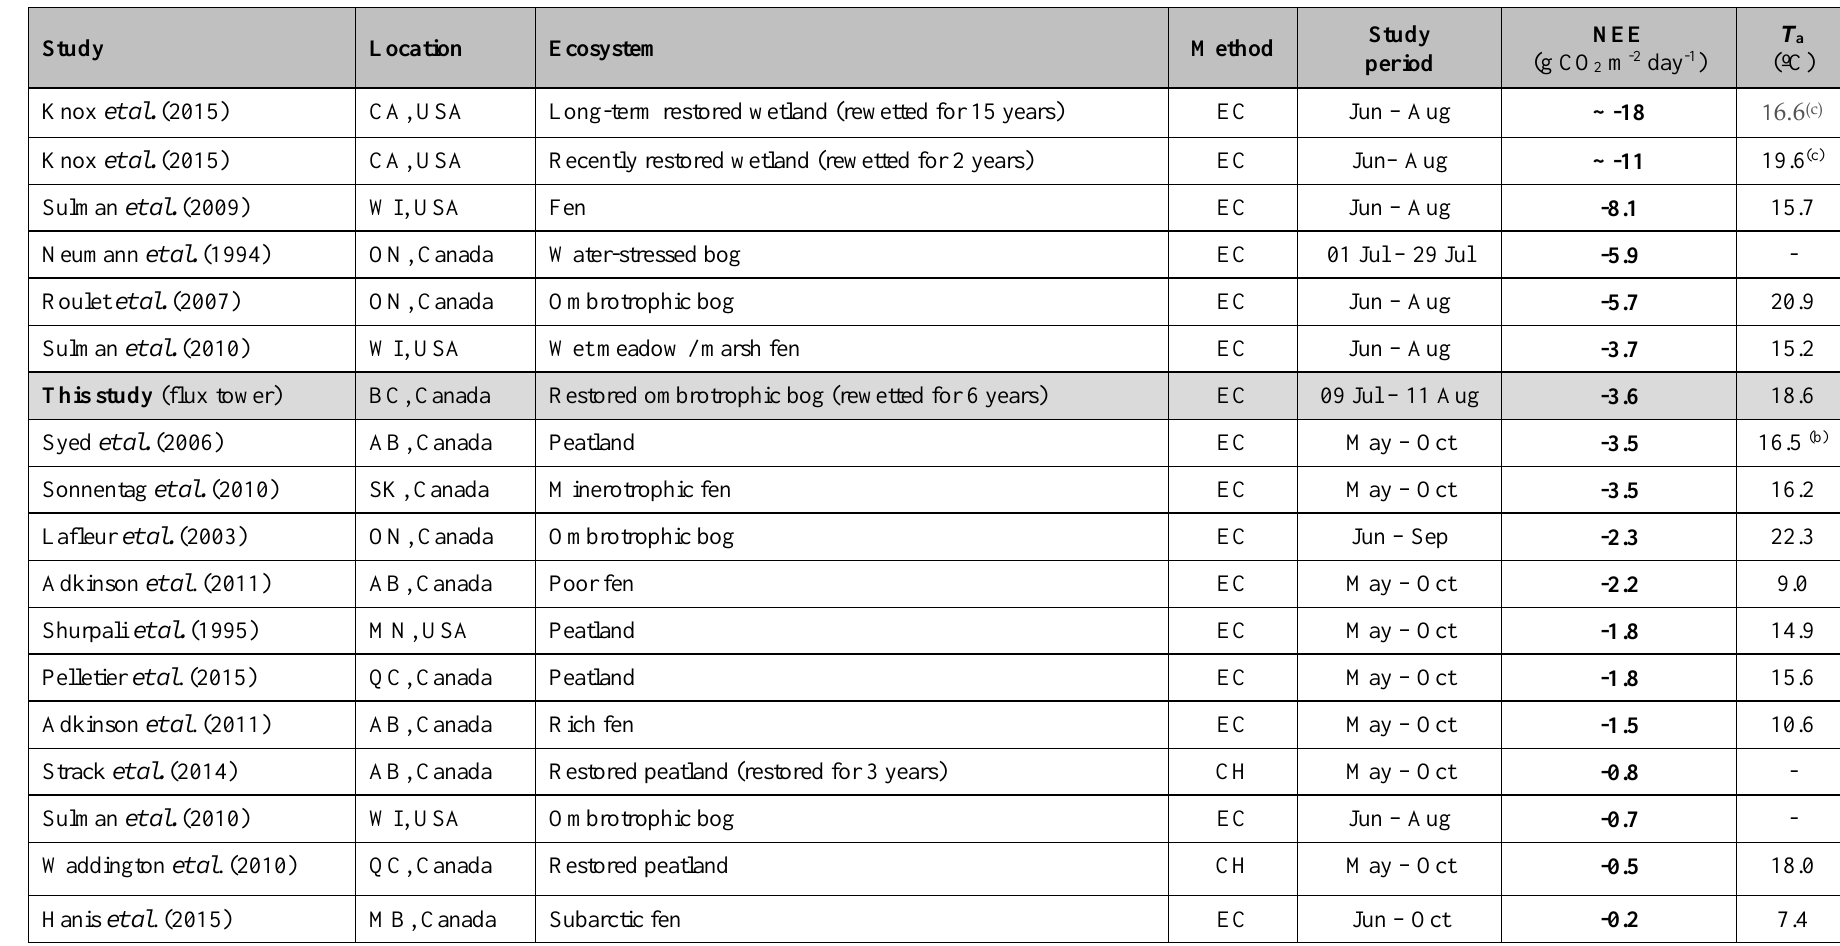
Table 5. Comparison of summertime net ecosystem exchange (NEE) measured in various undisturbed and restored temperate and boreal wetlands in North America using eddy covariance (EC) with the EC-measured values in this study. For comparison, the results of selected chamber studies from rewetted peatlands are also shown. Entries are sorted by increasing NEE (strongest CO 2 sink at top, weakest sink at